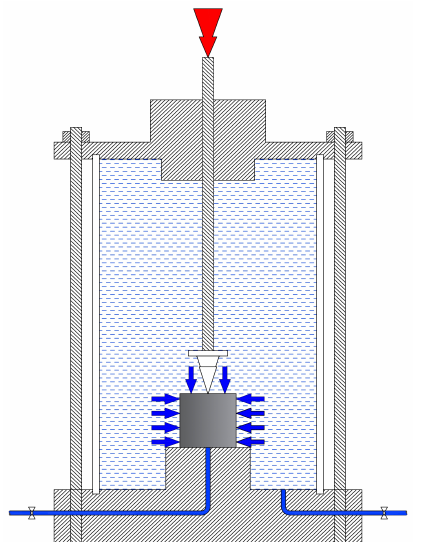
Figure 11. The basic principle and equipment for larger samples’ (d = 150 mm) triaxial test per- formance.